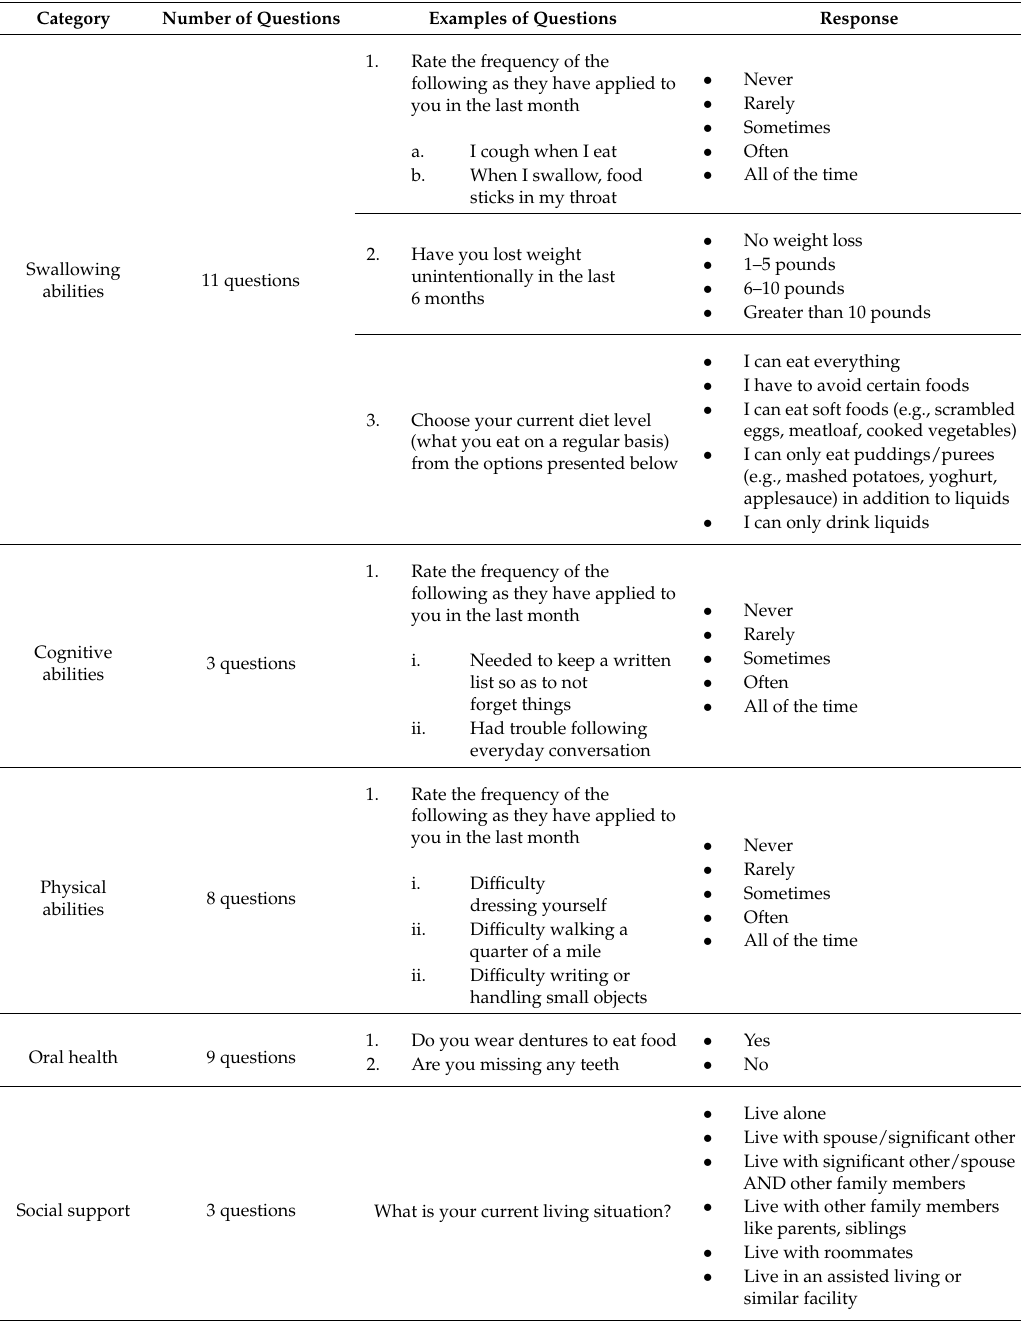
Table 1. Examples of questions in each category. Examples of questions are provided for each of the tool’s categories—swallowing abilities, cognitive abilities, physical abilities, oral health,